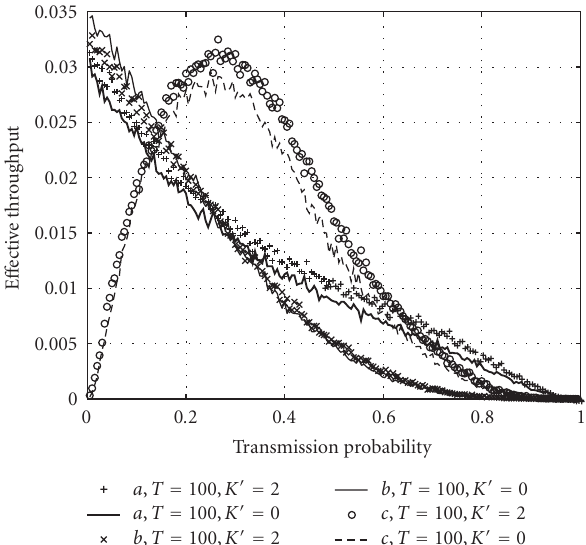
Figure 28: The e ff ective throughput of the dynamic ( K (cid:5) = 2) and the static ( K (cid:5) = 0) cases for K = 4 and T = 100 (connections d and e of the asymmetric network of Figure